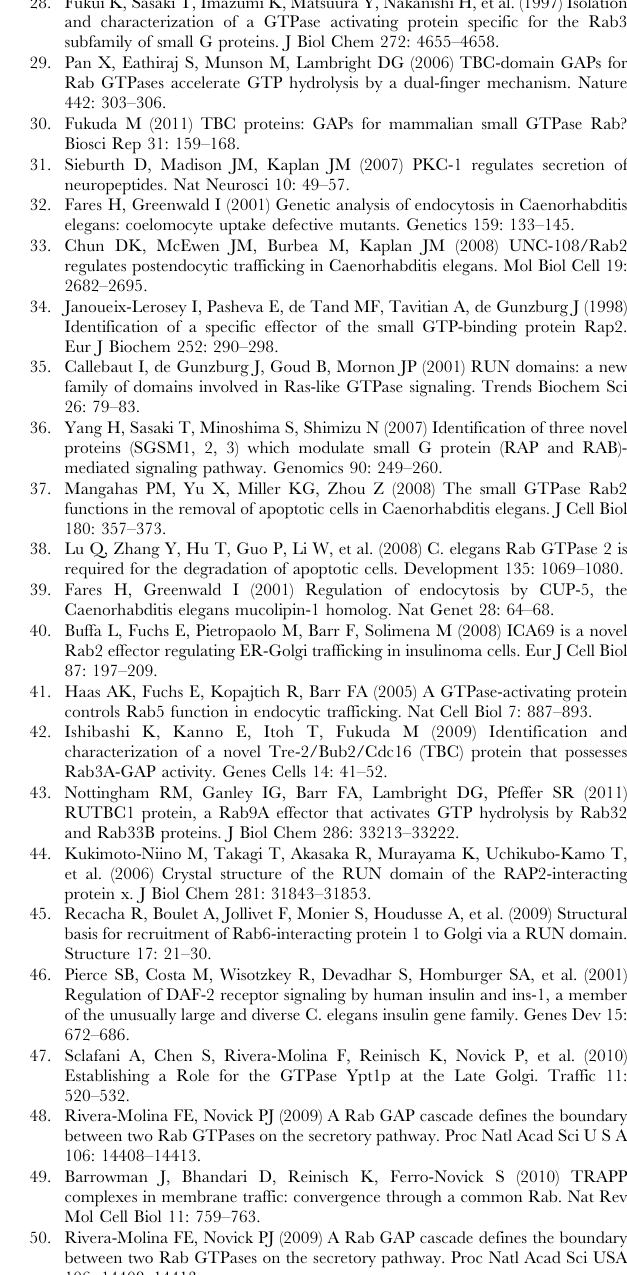
Table S1 Strains used in this study. (PDF) Table S2 Transgenic arrays used in this assay. (PDF) Table S3 Constructs used in this study.